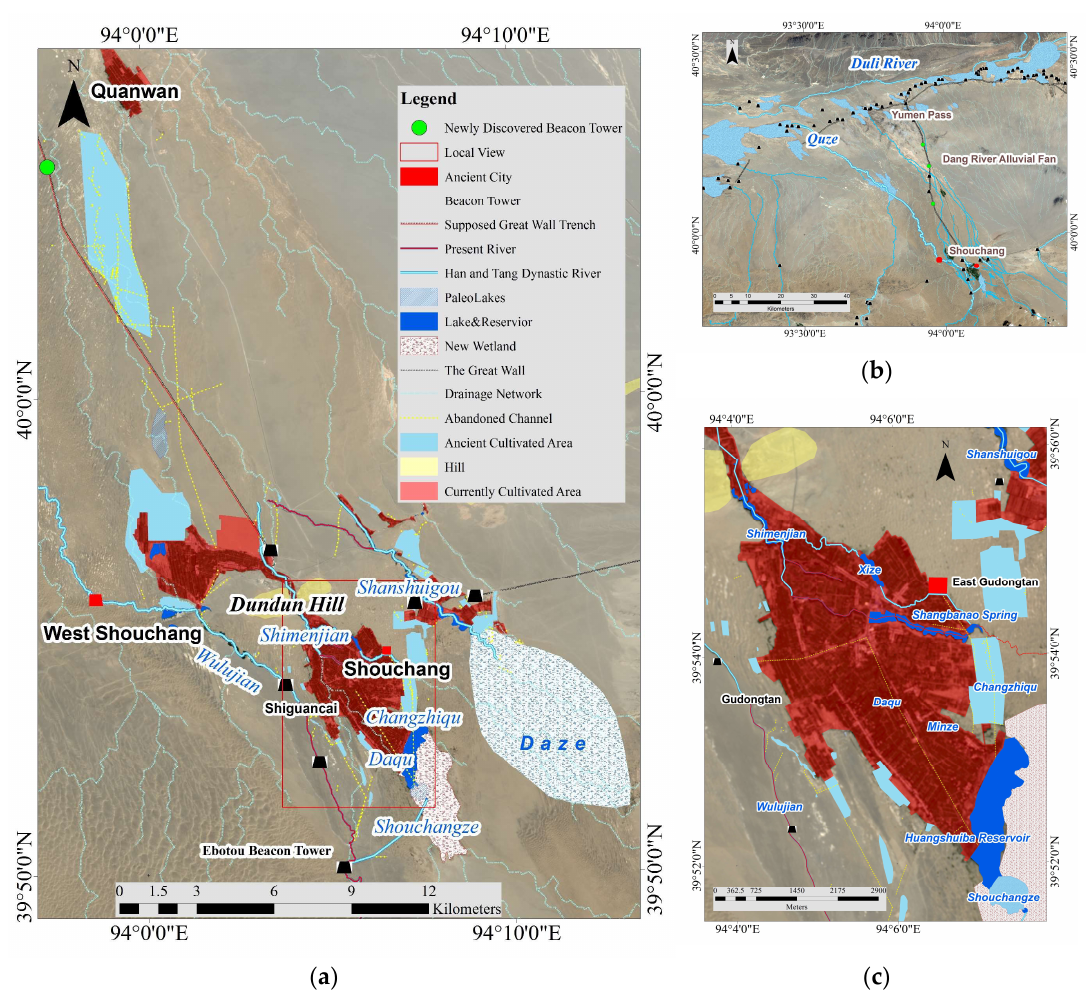
Figure 15. ( a ) Reconstruction of the water cultivation paleoenvironment of the Han and Tang dynasties; ( b ) water cultivation distribution of the Nanhu oasis in the Yangguan-Yumen frontier pass area; ( c ) magnified view of the area outlined in red in ( a ).